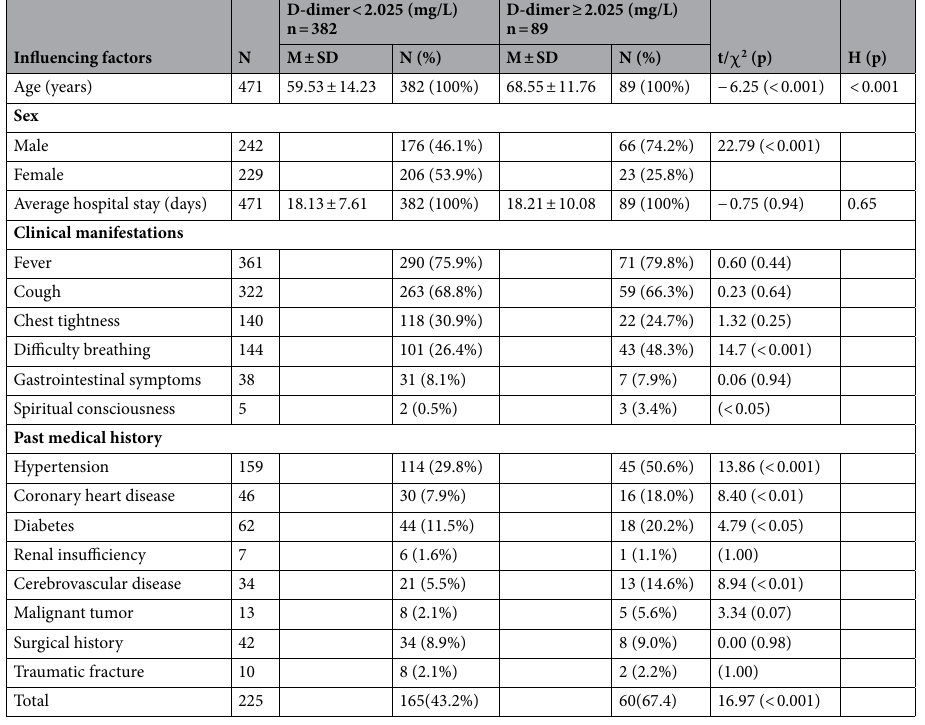
Table 5. Influencing factors of